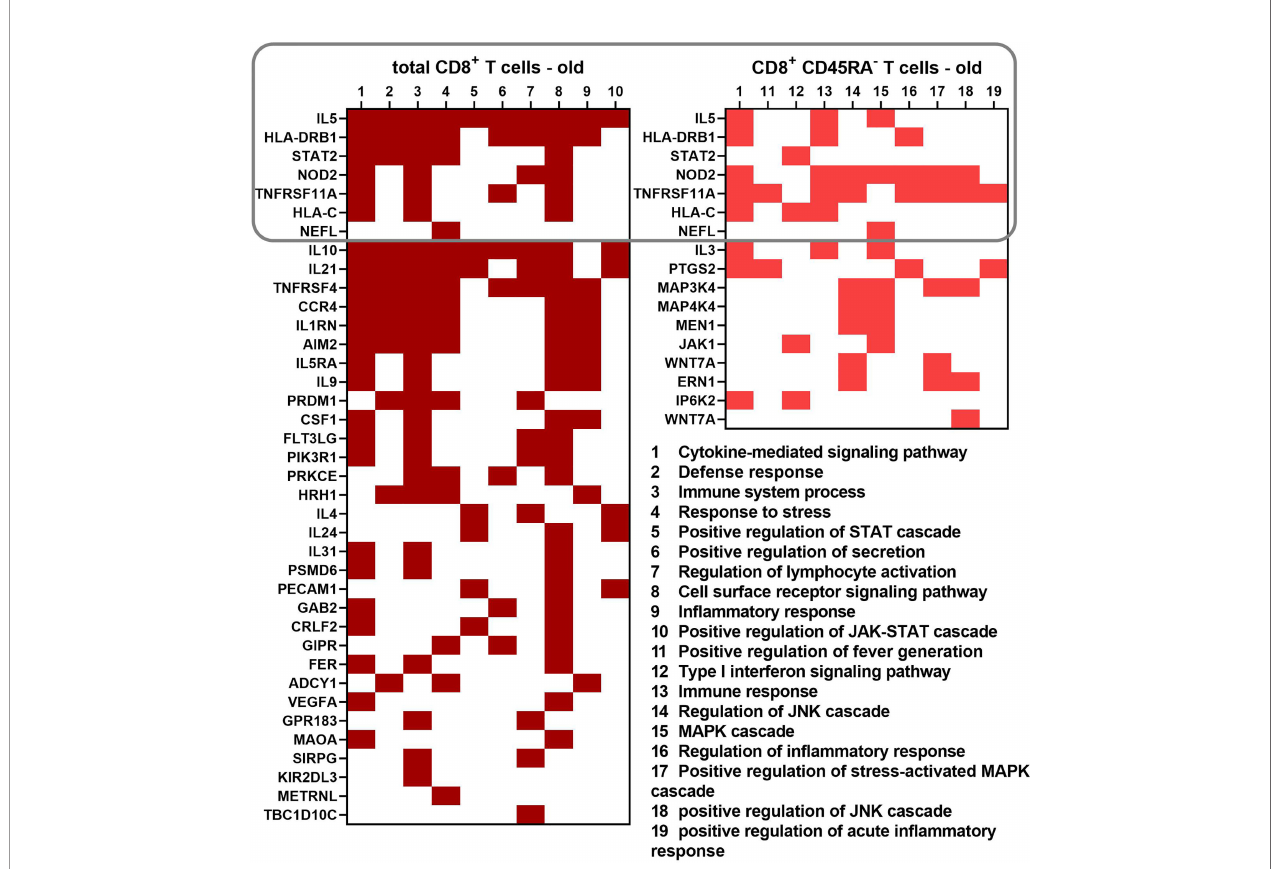
FIGURE 6 | Differentially expressed genes leading to 10 biological process GO terms with the lowest p values for the total and memory CD8 + T cell subpopulation of old donors. A binary heatmap (red = yes, white = no) was established using the biological process GO terms with the lowest p values from both old groups. A rectangle indicates the transcripts common for both cell